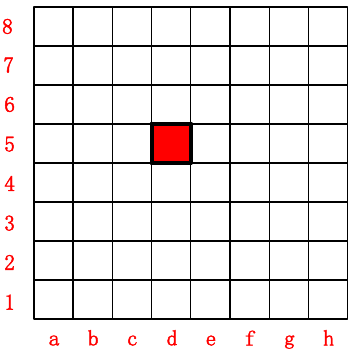
Figure 1. Representation methods of pixels and their edges.